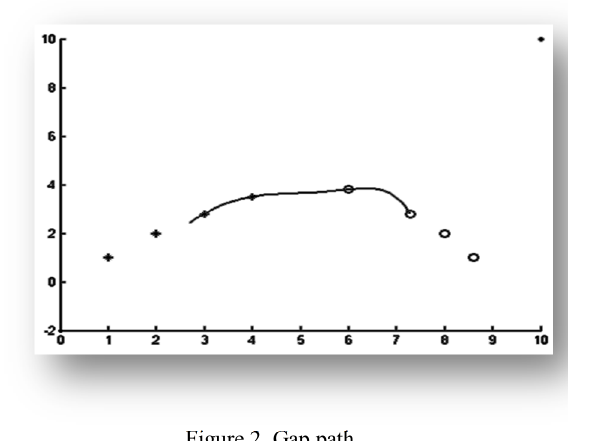
Figure 2. Gap path